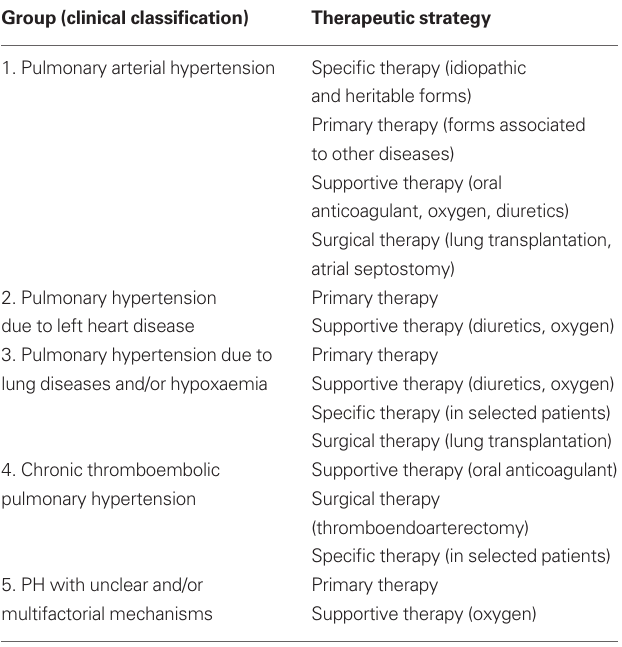
Table 5 | Therapy according to the clinical